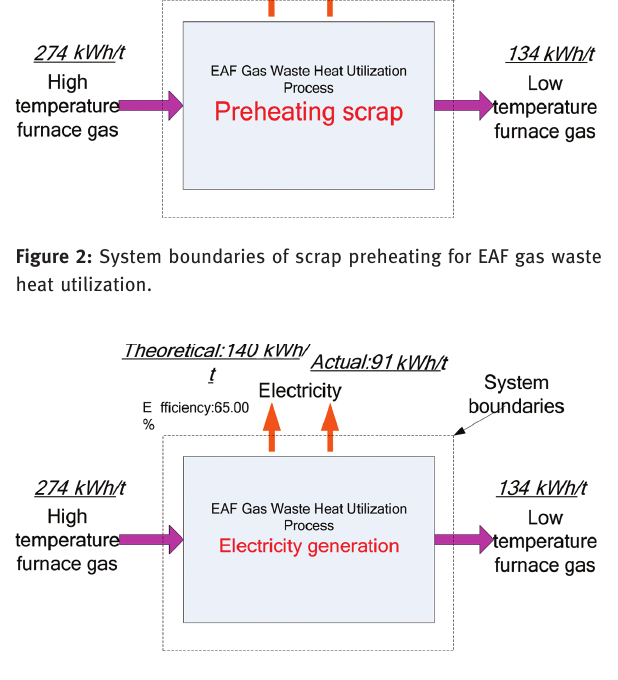
Figure 3: System boundaries of electricity generation for EAF gas waste heat utilization.